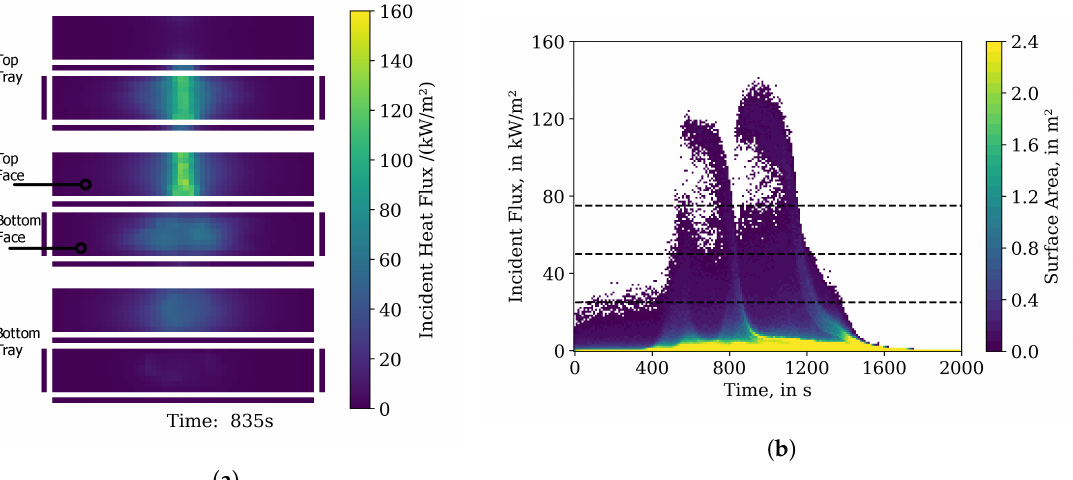
Figure A11. Simulation results showing the development of the INCIDENT_HEAT_FLUX on the cable tray surface for the best material prameter set of IMP T b . ( a ) Unfolded tray surface for a single time step, see also Figure 2a. ( b ) Histogram heat map over the whole tray surface, per time step. External flux for Cone Calorimeter experiments shown as dashed lines. Cells of zero heat flux are omitted (white).